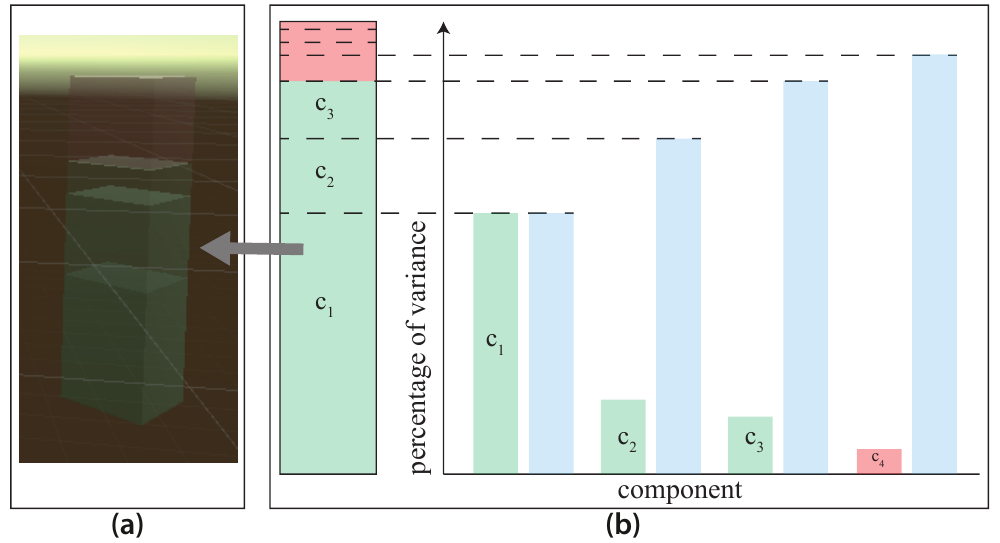
Figure 8. The Information Loss Component, explained by ( a ) the resulting 3D component as a stacked bar, and ( b ) the composition of the stacked bar, which is generated by the variance of the